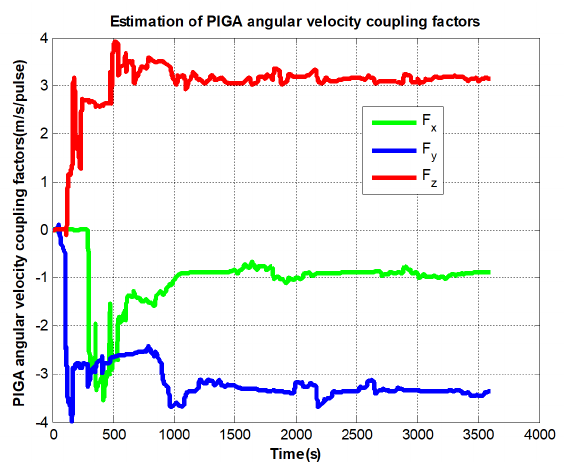
Figure 10. PIGA’s angular velocity coupling factors estimation curves.